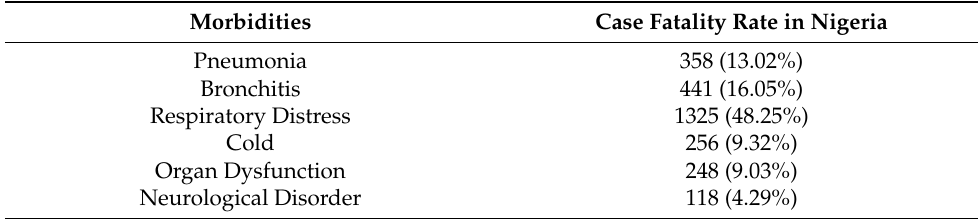
Table 7. Morbidity Rate versus the Case Fatality Rate of COVID-19 in